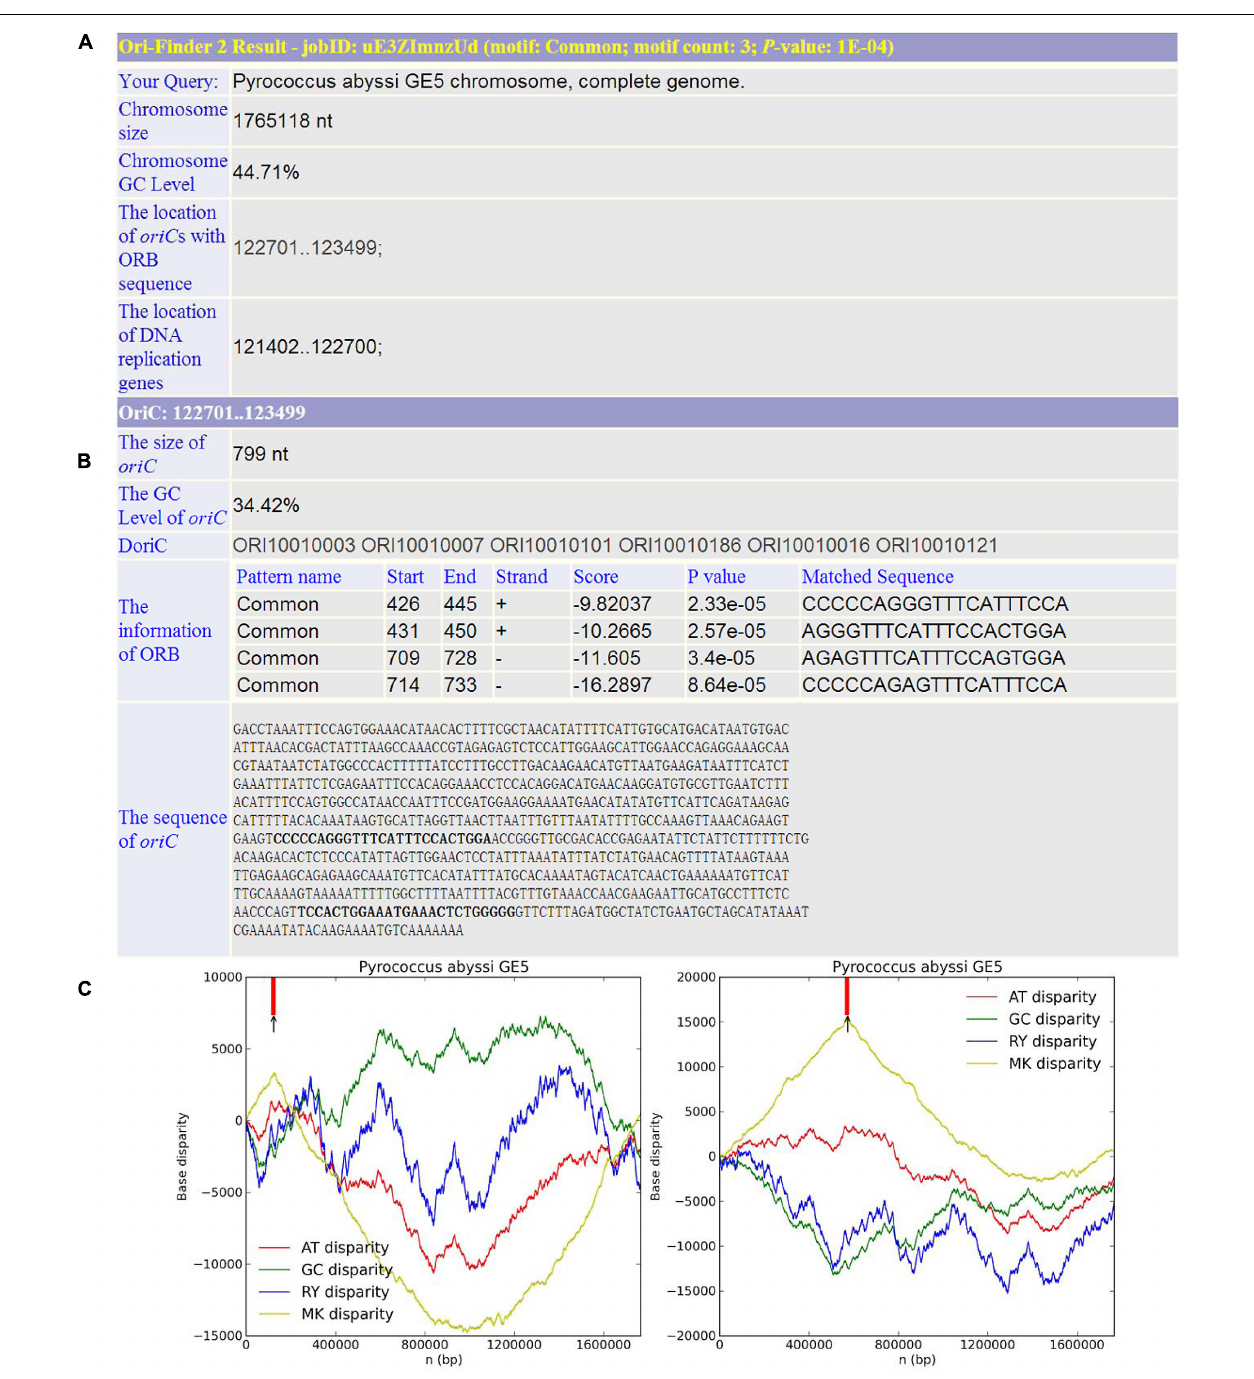
measure the similarity between the ORB motif and the matched sequence, and the P value cutoff for FIMO motif searching is 10 − 4 .The ORB motif used here is the common motif. (C) The left figure shows the Z-curves (AT, GC, RY, and MK disparity curves) for the original sequence, and the right figure shows the Z-curves (AT, GC, RY, and MK disparity curves) for the rotated sequence beginning and ending in the maximum of the GC disparity curve.The short vertical red line indicates the location of replication-related protein.The black arrow is the predicted oriC